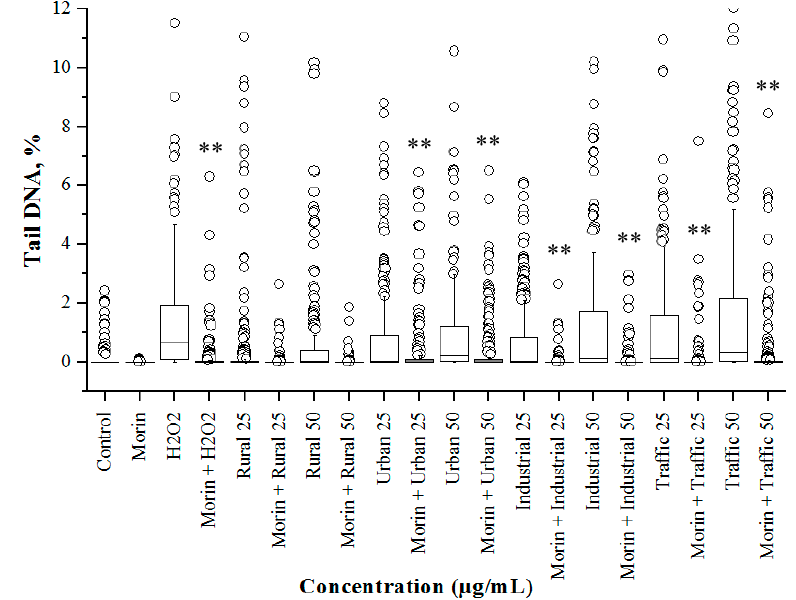
Figure 6. Plot of the distribution of DNA damage (% tail DNA) in morin pretreated (2 h) A549 cells treated with PM 2.5 for 4 h at 37 °C. The boxes include 50% of the data. The inner line marks the median value and whisker lines extending from the box represent the minimum and maximum values. H 2 O 2 (100 mM, 5 min at 37 °C) was used as the positive control. Small circles represent outliers. * p < 0.05; ** p < 0.01.